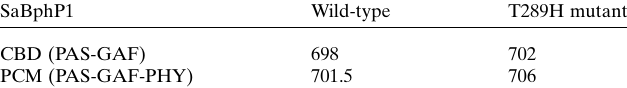
Table 3 Absorption maxima (in nm) for wild-type and T289H mutant of